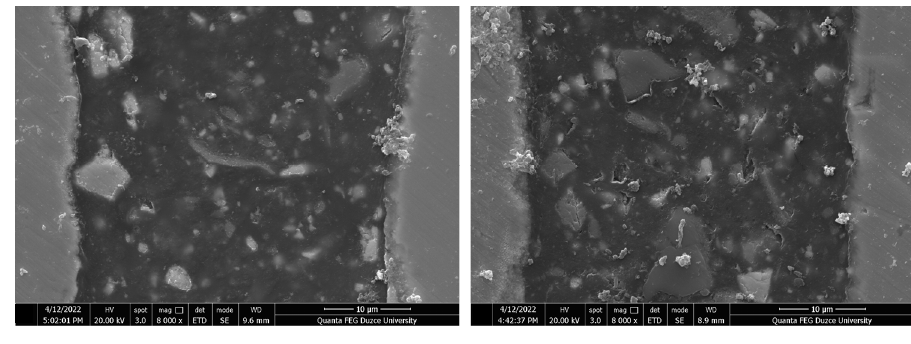
Figure 5. Interface images of bonded joints. Figure 2. Interface images of bonded joints.